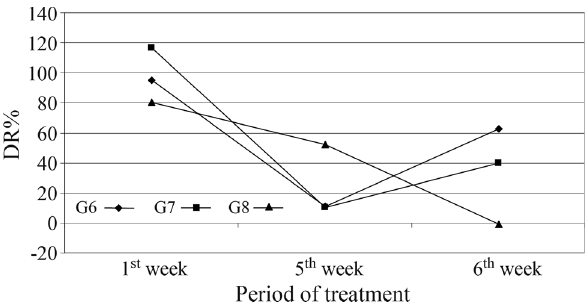
Figure 1 - Antimutagenic behavior of the (cid:2) -glucan molecule measured by DR% in the micronucleus